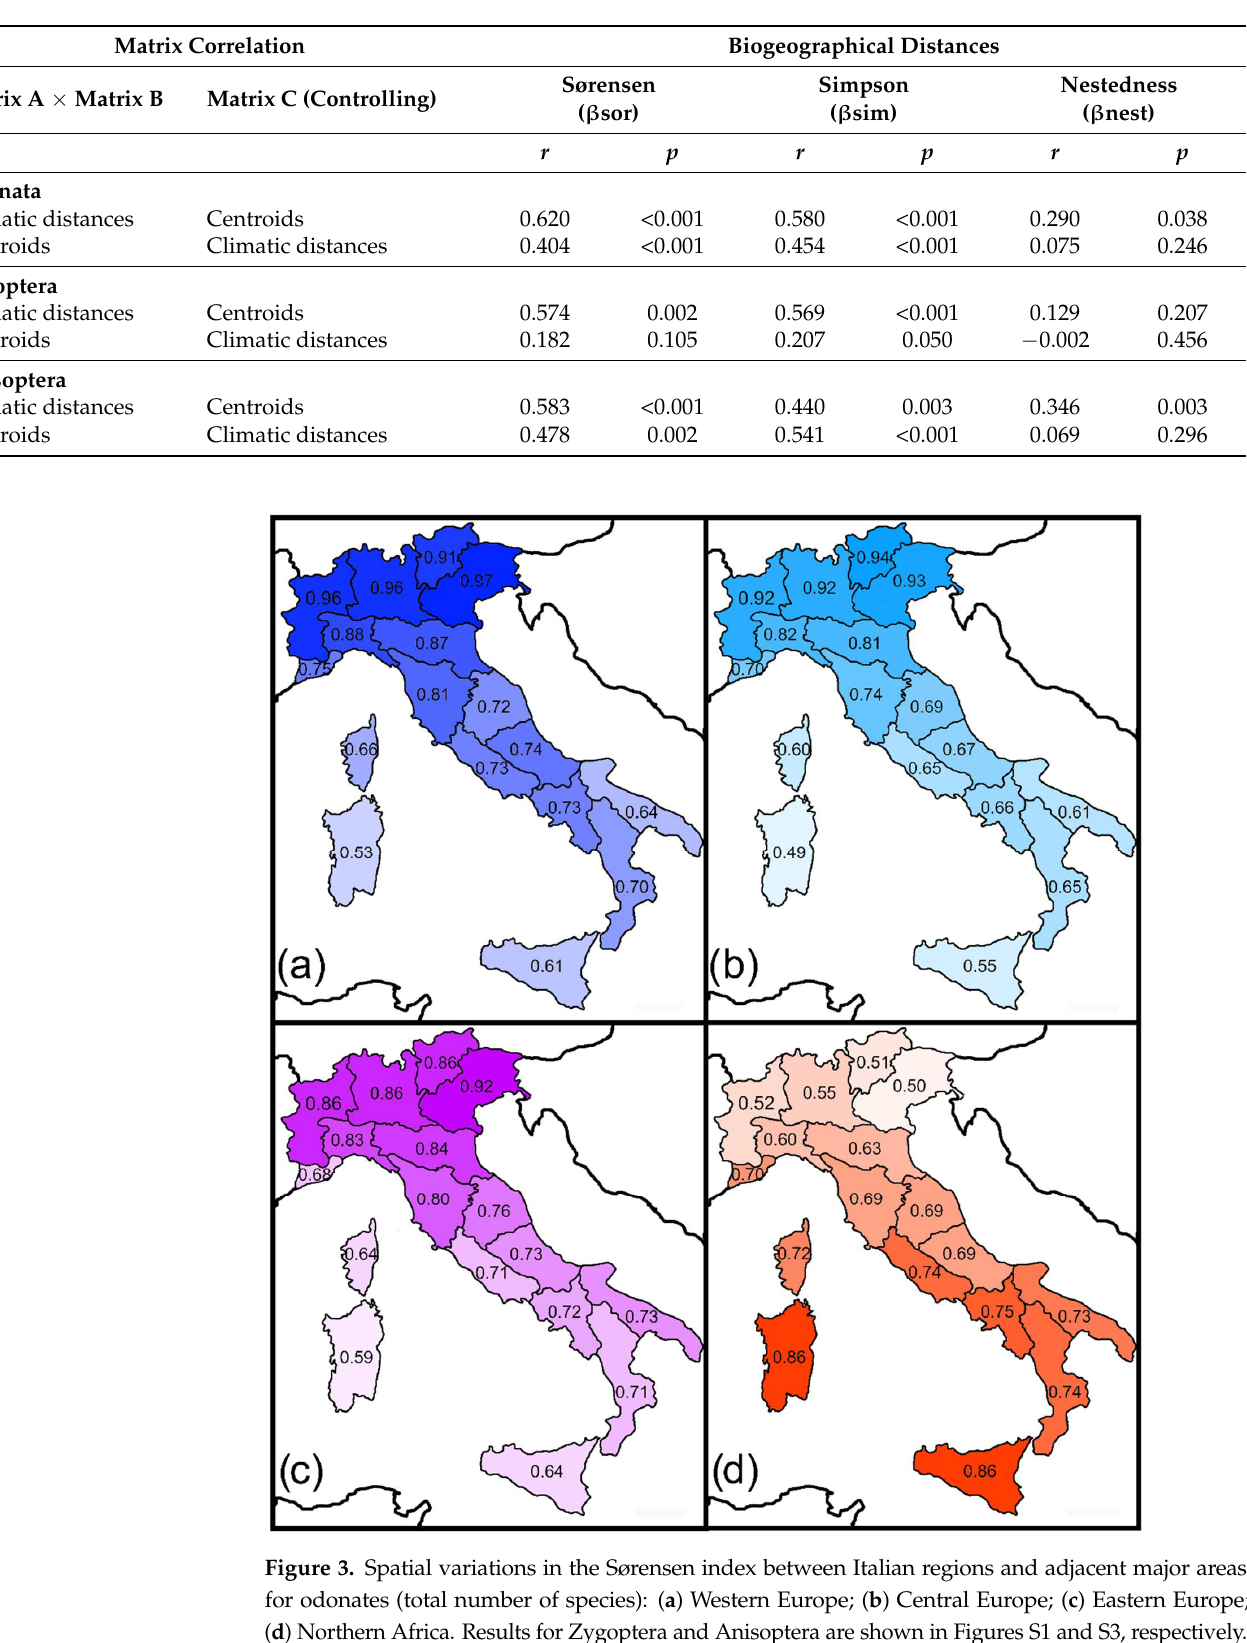
Table 2. Partial Mantel tests of biogeographical distances against climatic and geographical distances for Italian odonates.